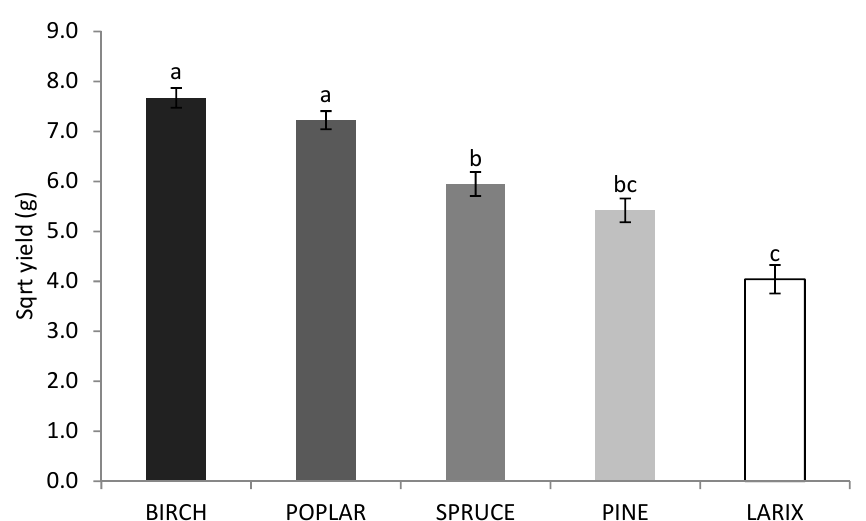
Figure 2. Effect of the wood substrate on the fruiting body yield of G. lucidum estimated in Equation (2). Significant differences ( p < 0.05) between the square root yields are represented with different letters (a, b and c).